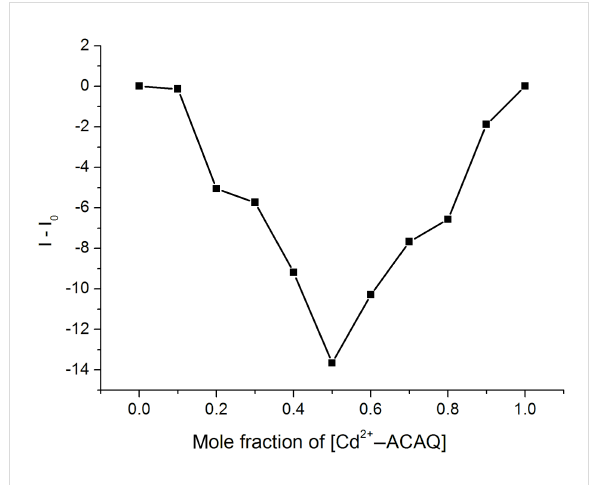
Figure 4: Job’s plot of Cd 2+ –ACAQ in 10 mM HEPES buffer (pH 7.4) at 298 K. The sum of the concentrations of the host and D - Cys is 5 µM (emission at 500